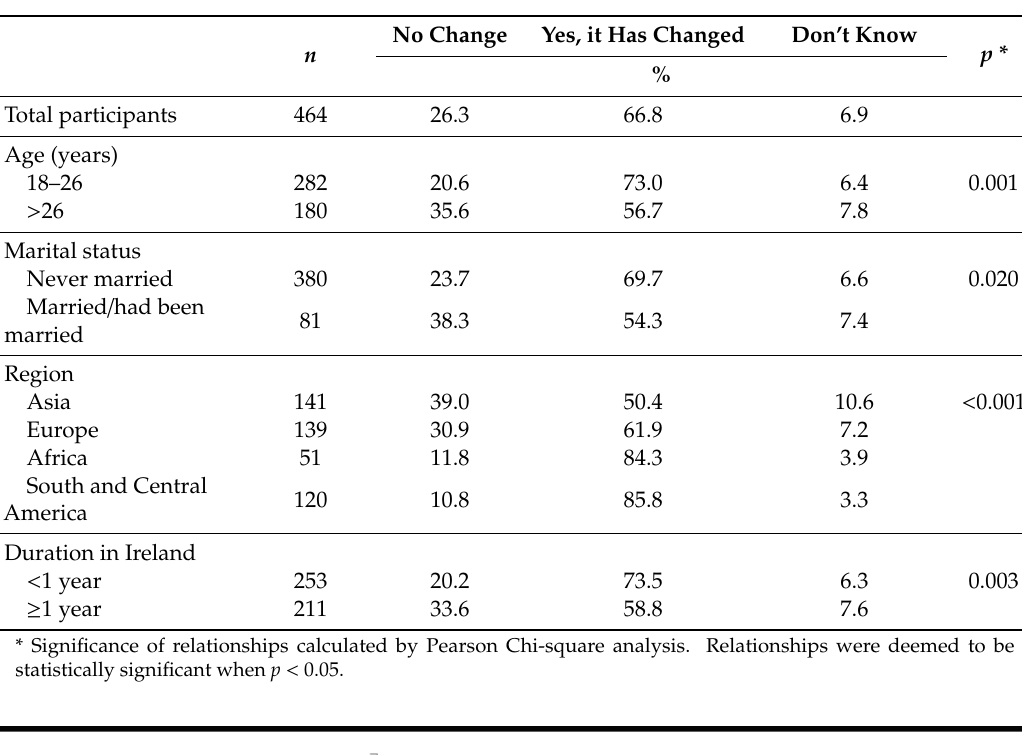
Table 6. Perceived dietary change of international students in Ireland.